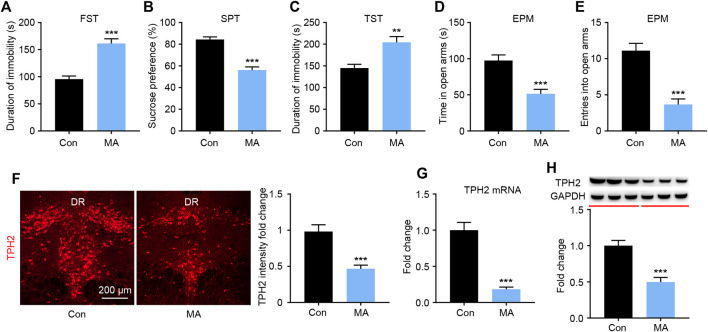
Effects of chronic MA administration on depressive symptoms and DRN 5-HT synthesis. (A) Immobility time during the FST. (B) Sucrose preference in the SPT to illuminate anhedonia. (C) Immobility time in the TST. (D) Total time exploring the open arm of elevated plus maze. (E) Total entries into open arm of elevated plus maze. (F) TPH2 immunoreactivity in dorsal raphe (DR) of the mice brain, scale bar = 200 μm. (G, H) TPH2 expression was quantified by qPCR and WB. DRD; dorsal part of the DR, DRV; ventral part of the DR. Data are presented as the mean ± SEM. **p < 0.01, ***p < 0.001.